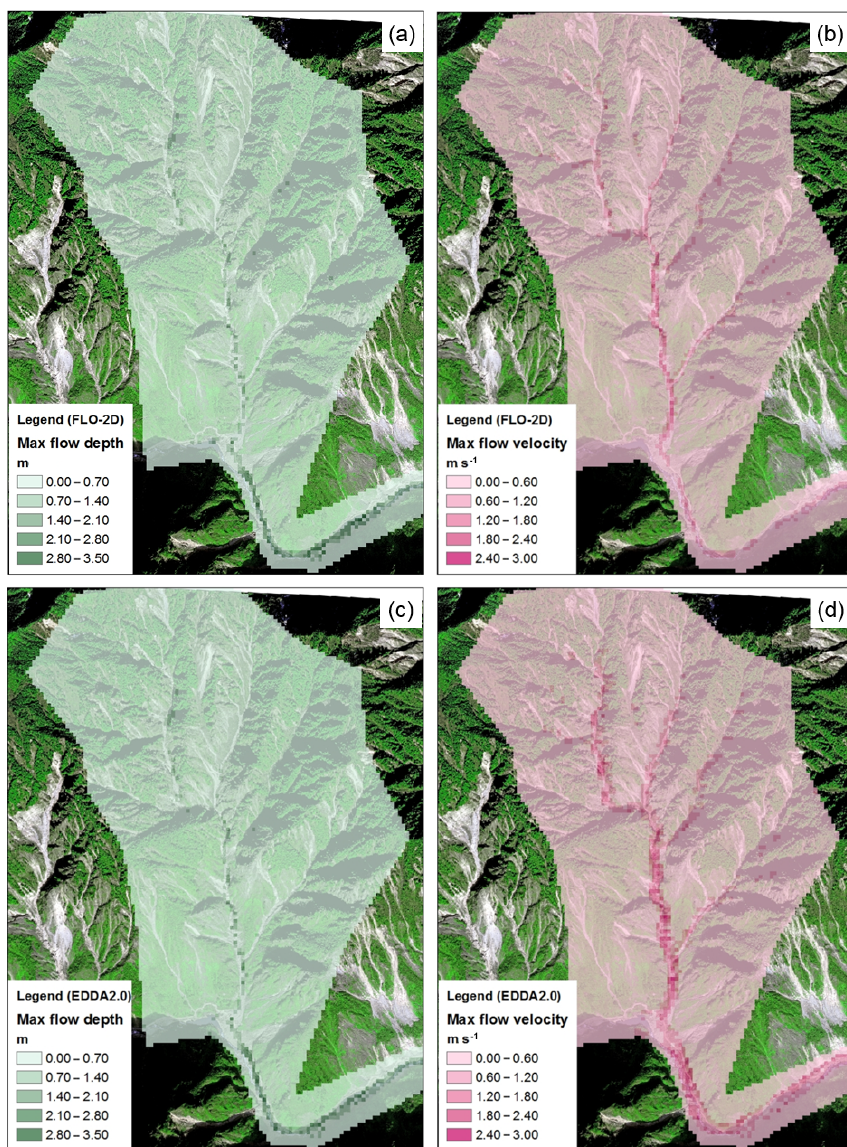
Figure 6. Comparison of the maximum surface runoff flow depths and flow velocities simulated using FLO-2D (a, b) and EDDA 2.0 (c, d)